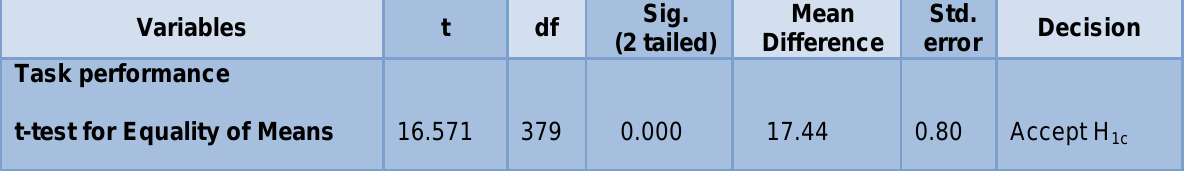
Table 5 Independent samples t-test of task performance of construction professionals in indigenous and expatriate construction companies df = Degree of freedom